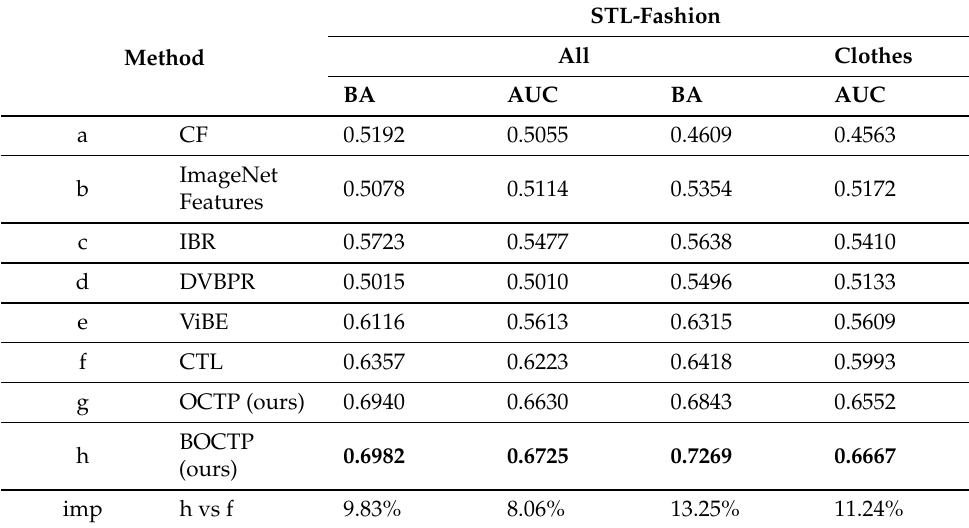
Table 4. Binary Accuracy (BA) and AUC on STL-Fashion dataset for non-label-given outfit completion. Under the dataset name, ‘all’ denotes the whole dataset which includes clothes, shoes and accessories, while ‘clothes’ only contains clothing